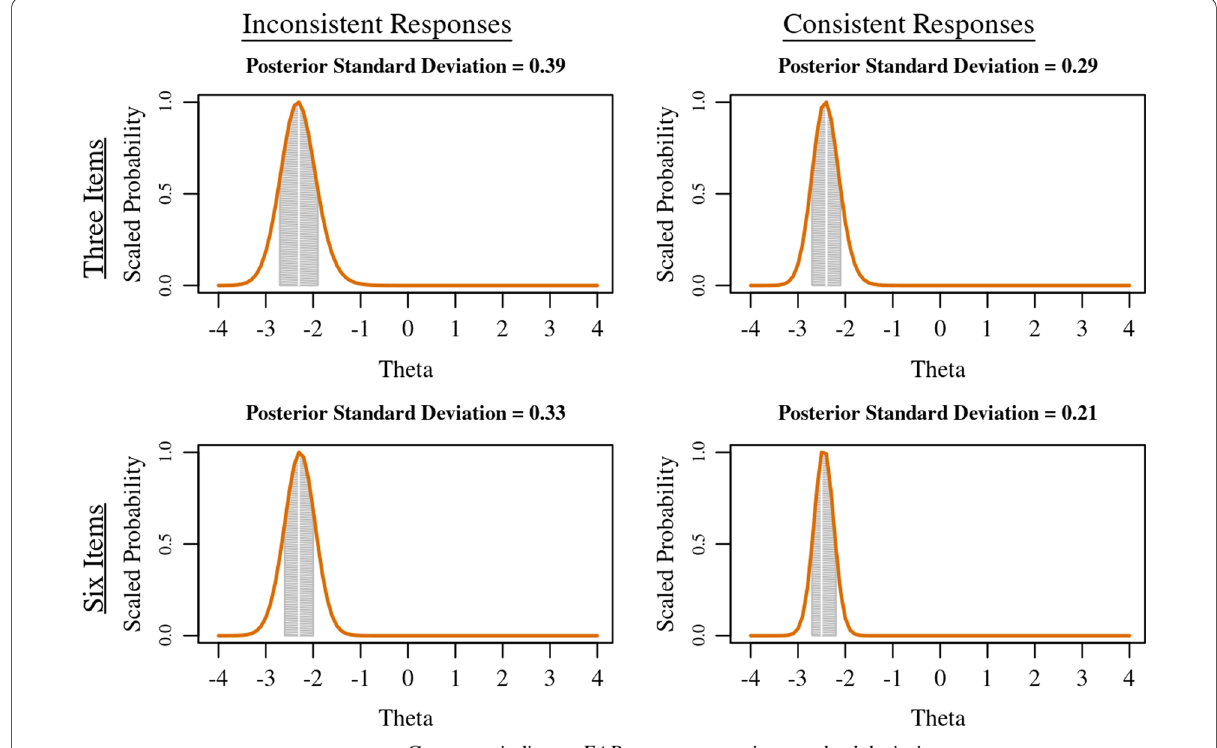
Fig. 11 Posterior standard deviation, number of items and response